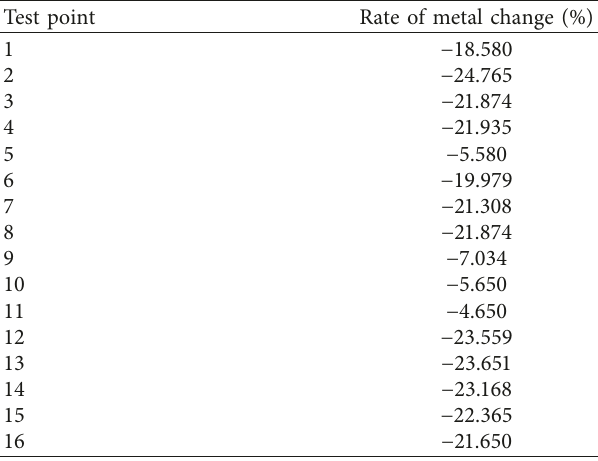
Figure 12: FLC forming limit diagram of fender. Table 10: Rate of metal change at each